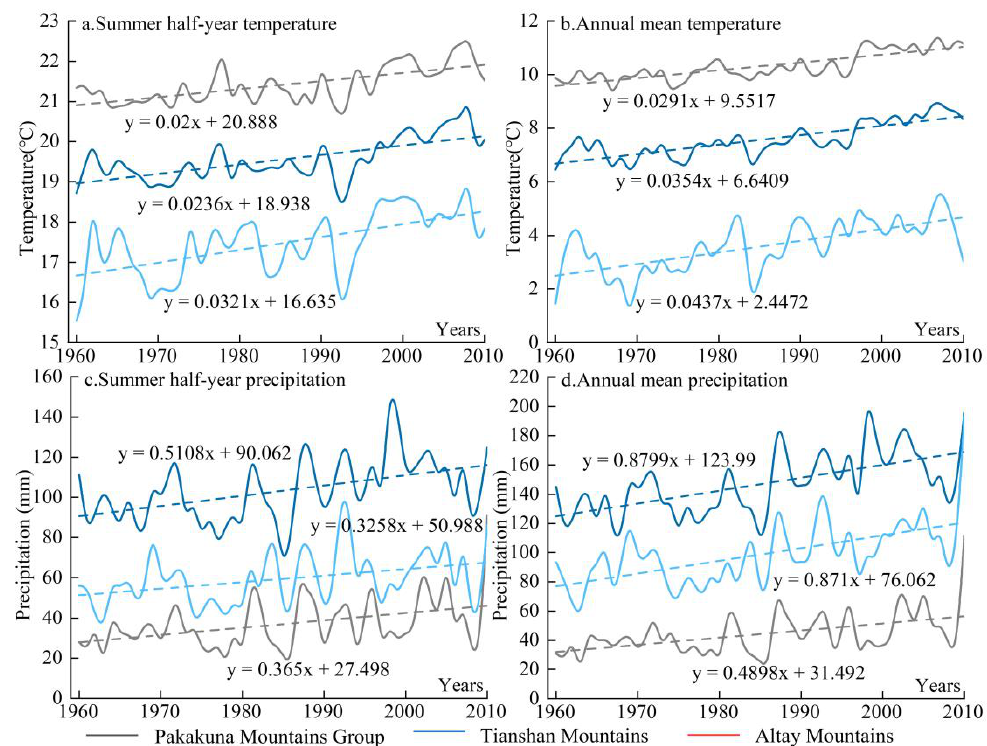
Figure 9. Changes in temperature and precipitation in Xinjiang during the whole year and summer from 1960 to 2010. Summer half-year temperature ( a ); Annual mean temperature ( b ); Summer half-year precipitation ( c ); Annual mean precipitation ( d ).